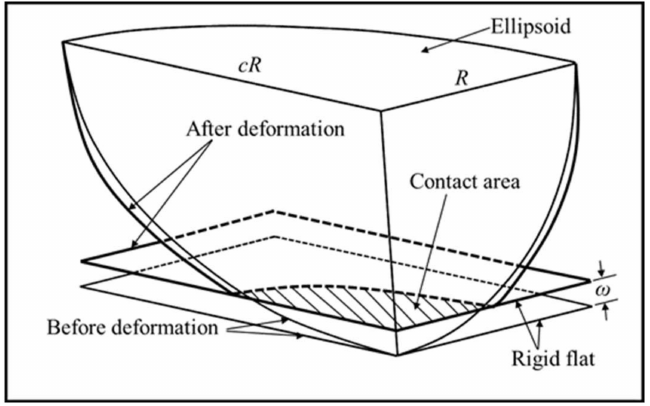
Figure 1. Contact diagram of an ellipsoid with a rigid